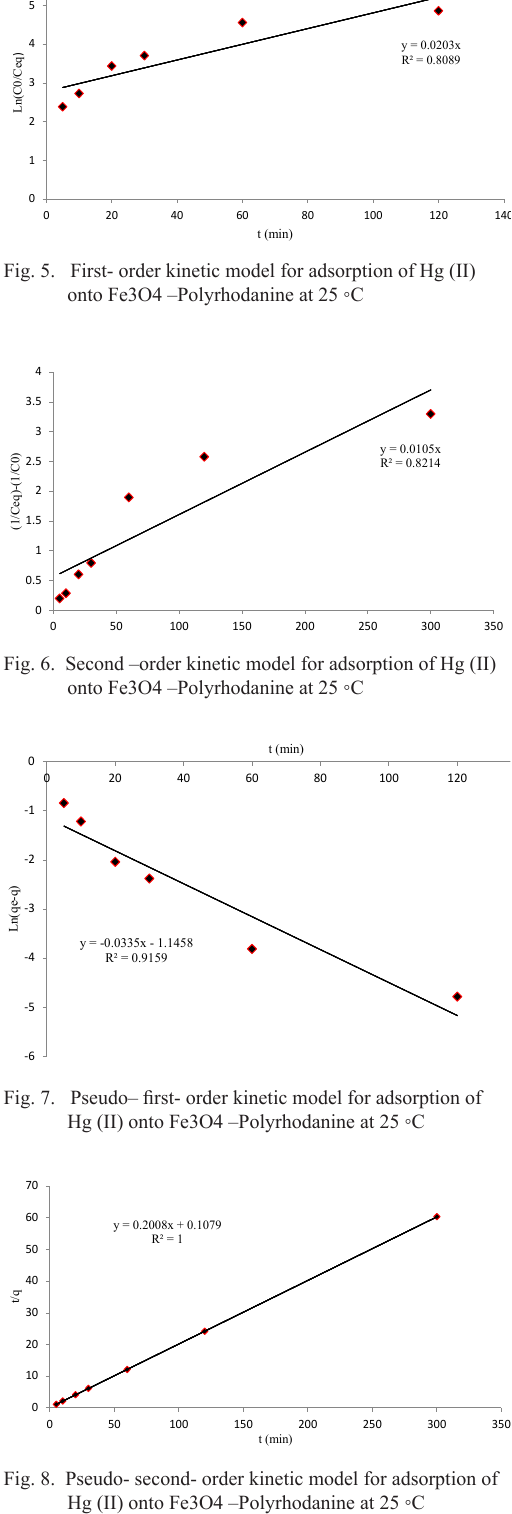
y = 0.0203x R²=0.8089